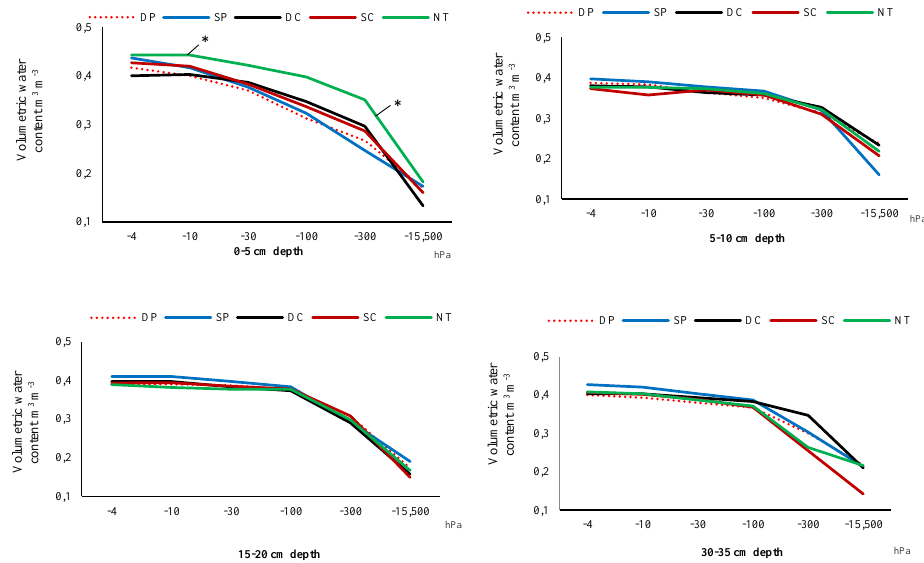
Figure 4. Effect of tillage intensity on soil water retention capacity in different soil layers, 2017. Notes: DP—deep ploughing (control treatment); SP—shallow ploughing; DC—deep cultivation; SC—shallow cultivation; NT—no tillage (direct drilling). *—significant difference at 0.01 < p ≤ 0.05. The significance of data was determined by Fisher’s least significant difference (LSD) test.